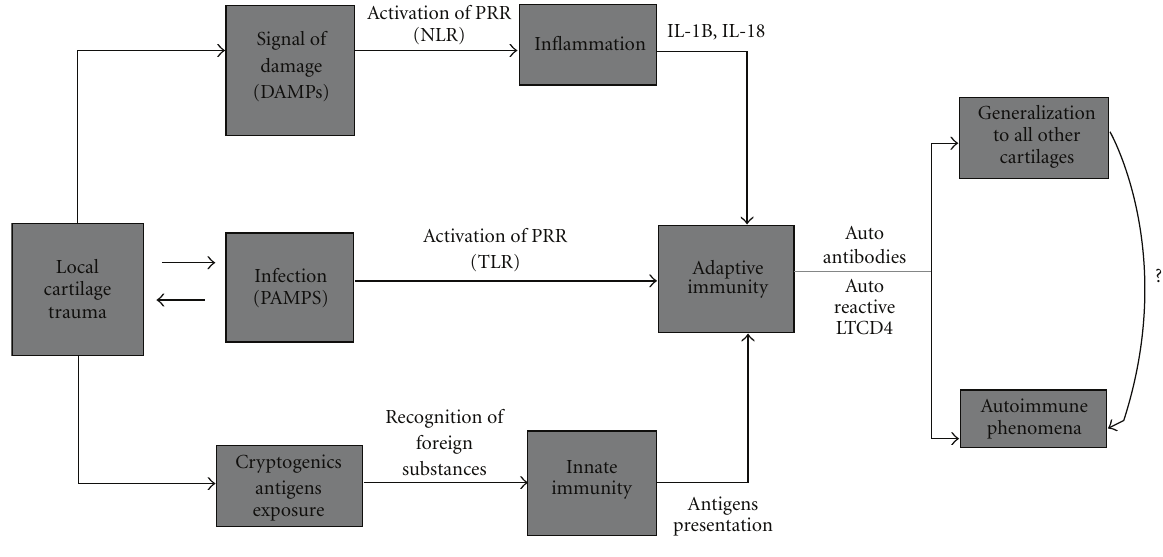
Figure 1: Local cartilage trauma initiates an inflammatory process with or without infection as coadjuvant as well as activation of the innate and adaptive immunity through induction of PAMPs, DAMPs, and cryptogenic antigens which are recognized by PRR (TLR, NLR) that results in the production of IL-1B and IL-18. These interleukins amplify T and B cell responses and might serve as a crucial link into adaptive immune responses. PRR, pattern recognition receptors; TLR, Toll-like receptors; NLR, NOD-like receptors; LTCD4, lymphocytes T